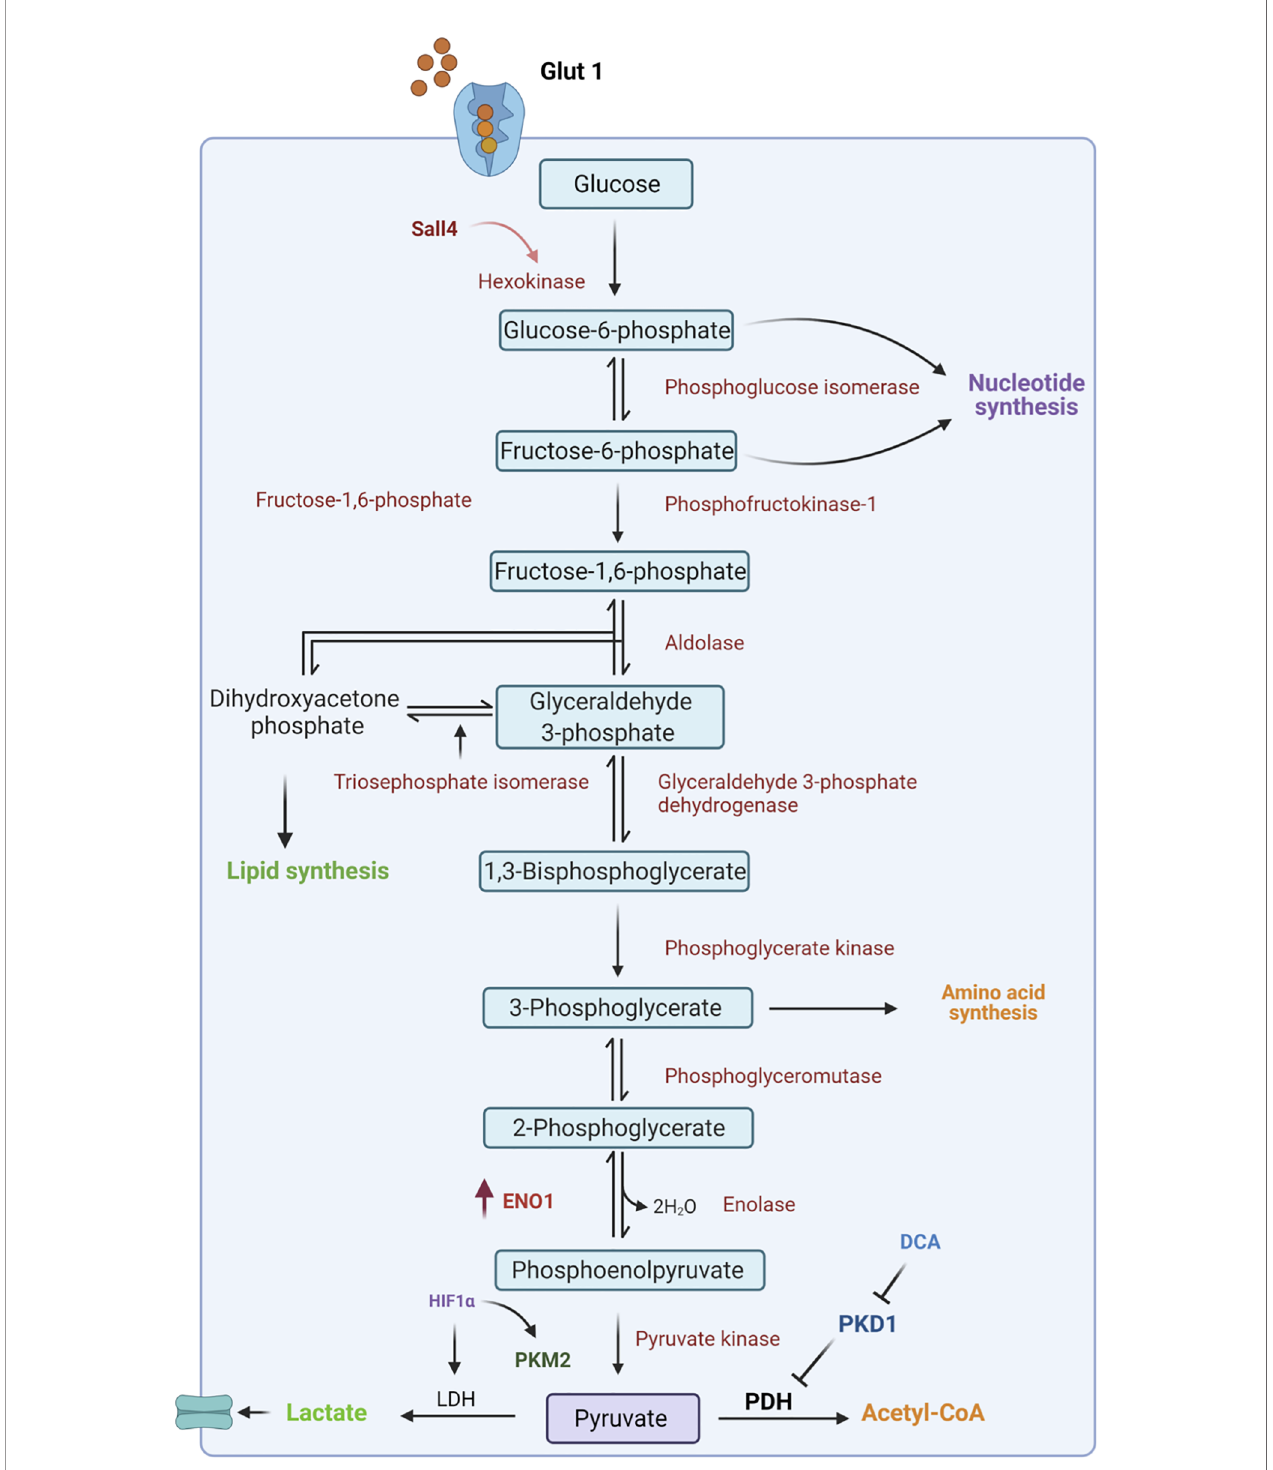
FIGURE 2 | Schematic representation of glycolytic pathway. In CSCs, glucose from the extracellular environment is mainly metabolized through glycolysis. In particular, upregulation of several intermediates of this catabolic pathway, such as Hexokinase 2 and ENO1, leads to an increase in lactate production. Moreover, the inactivation of pyruvate dehydrogenase (PDH) by PDK1 is responsible for failure in the conversion of pyruvate to Acetyl-CoA and this results in increased lactate production. ENO1, Enolase1; HIF1 a , hypoxia-inducible factor; LDH, Lactate Dehydrogenase; PKM2, Pyruvate kinase isozyme M2; PDH, Pyruvate dehydrogenase; PDK1, Pyruvate dehydrogenase kinase 1; DCA, dicloroacetate.